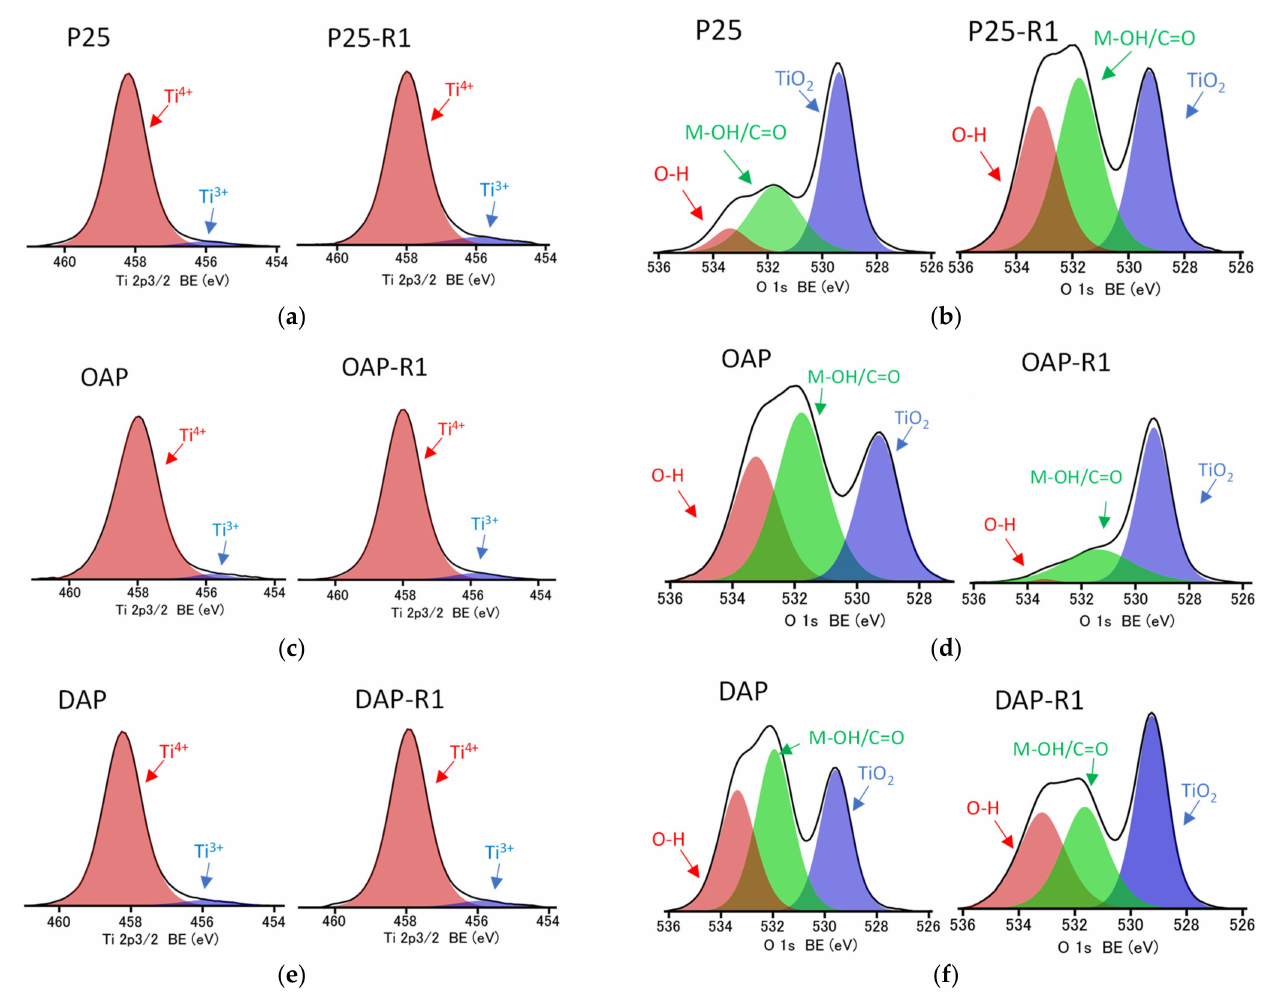
Figure 3. XPS data after deconvolution of titanium ( a , c , e ) and oxygen ( b , d , f ) peaks for pristine (on the left) and reduced (on the right) titania: ( a , b ) P25 and P25-R1; ( c , d ) OAP and OAP-R1; ( e , f ) DAP and